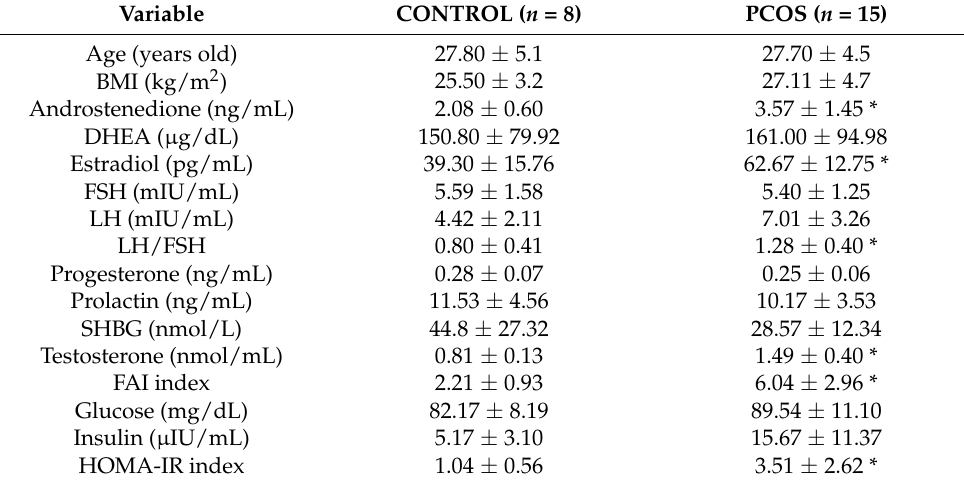
Table 1. Demographic and clinical characteristics of healthy women (CONTROL) and PCOS patients who participated in this